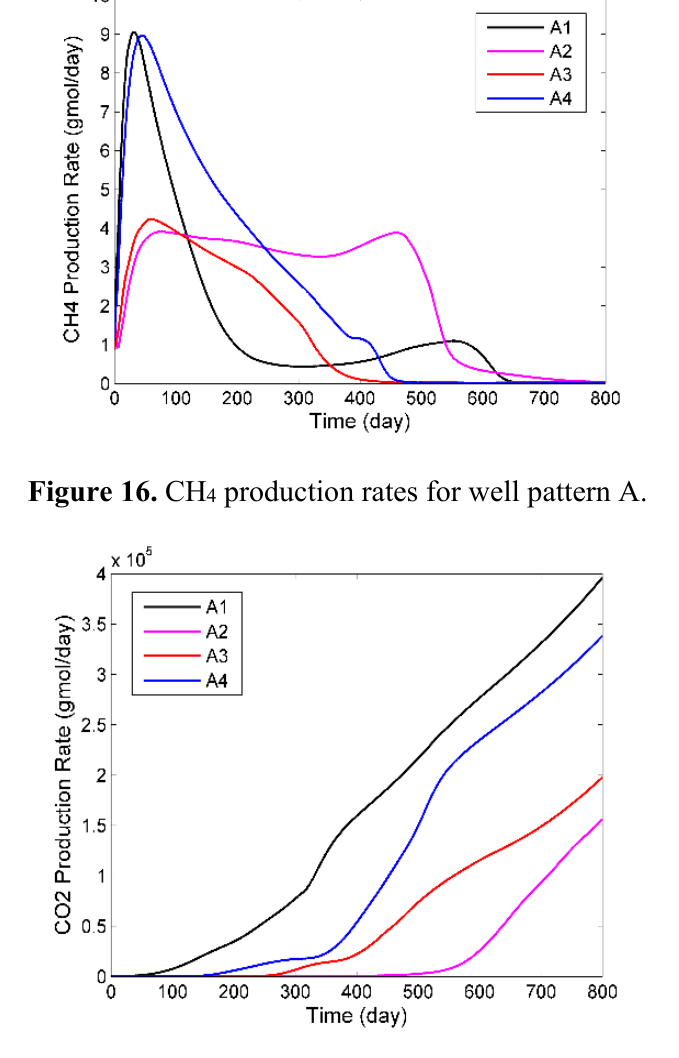
Figure 17. CO 2 production rates for well pattern